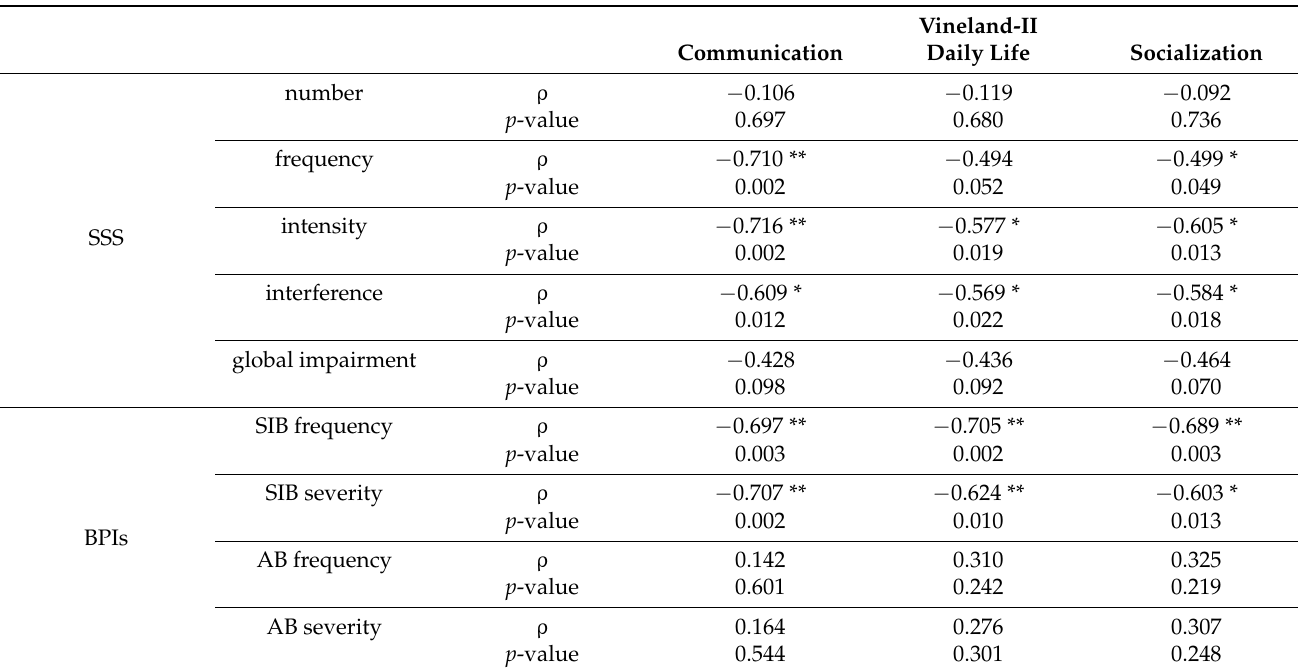
Table 3. Correlations between Vineland subscales and SSS and BPIs